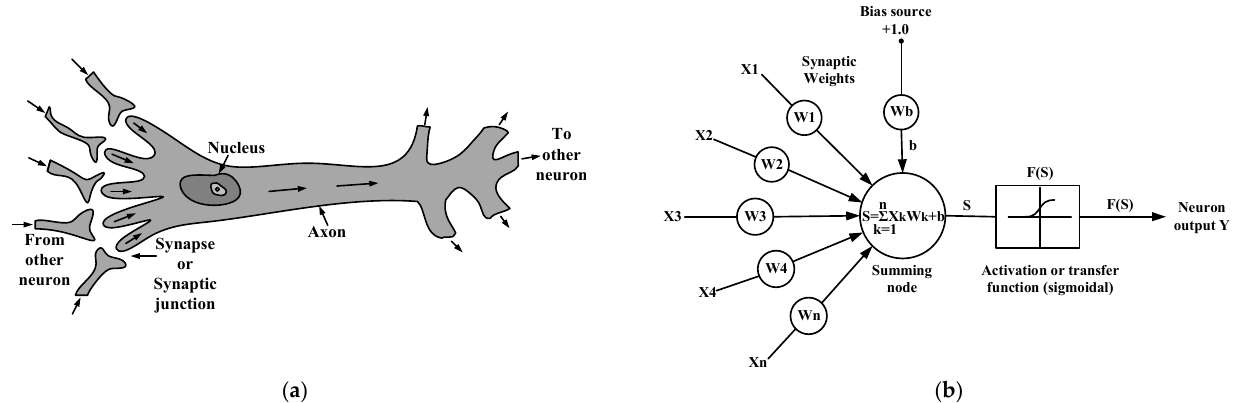
Figure 15. Resemblance between a biological neuron and an artificial neuron [106]. ( a ) Biological neuron, ( b ) artificial neuron.